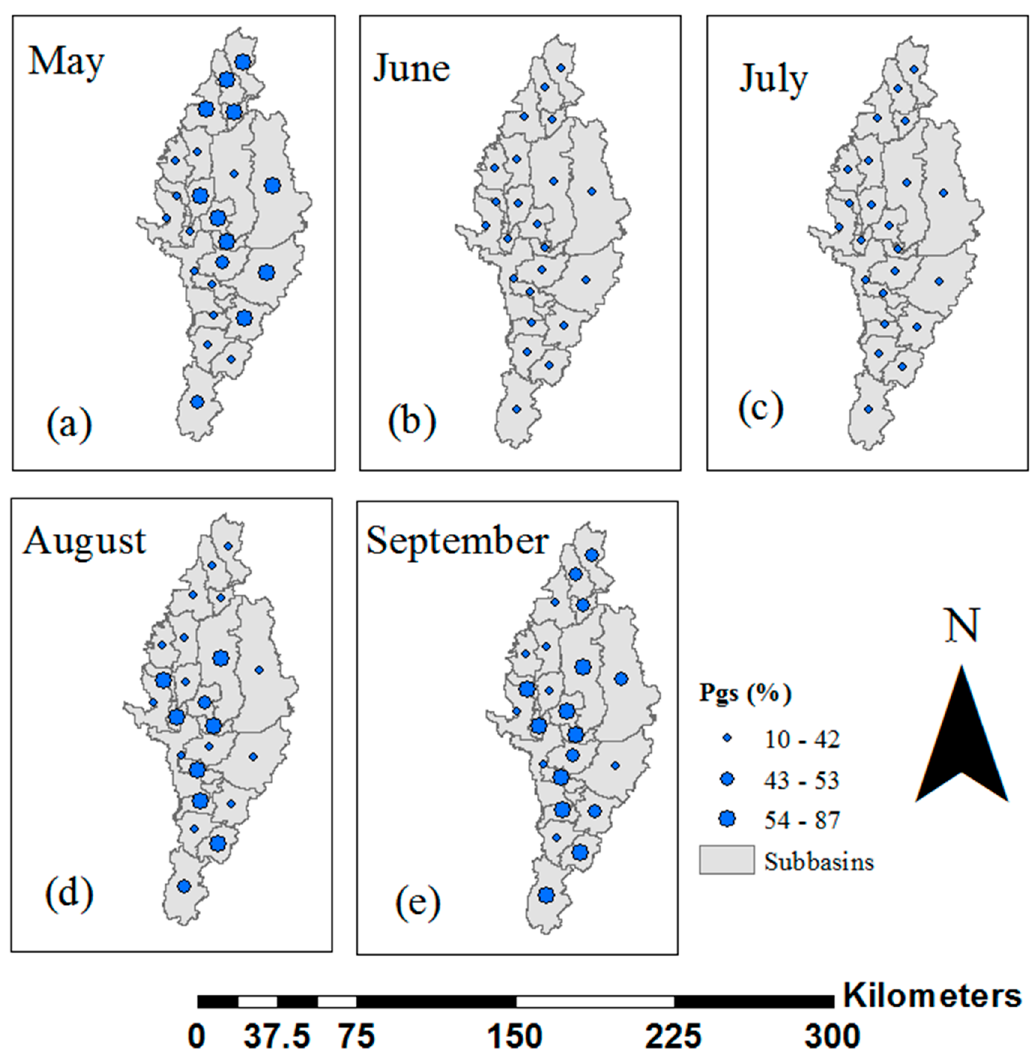
Figure 7. Percentage between weekly available surface water (P gs ) for irrigation and total irrigation requirement, averaged all weeks of each month in Big Sunflower River Watershed. * P gs was defined as: P gs = ASWR / total irrigation demands; * ASWR is defined as: ASWR = 80% SWRP + PWRP; SWRP is defined as: SWRP = SWR − (SE + ST), SWR is stream water resources, SE is stream water evaporation, ST is stream transmission; PWRP is defined as: PWRP = PWR − PE; PWR is pond water resources,